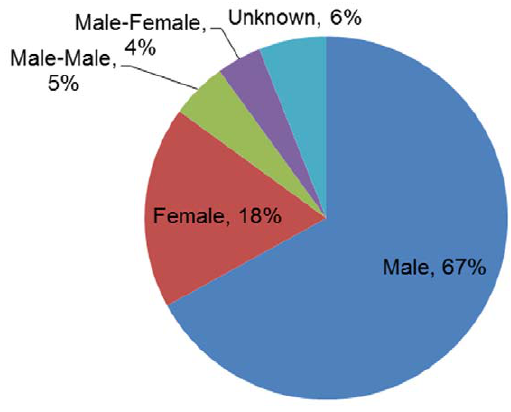
Figure 1. Distribution of gender among